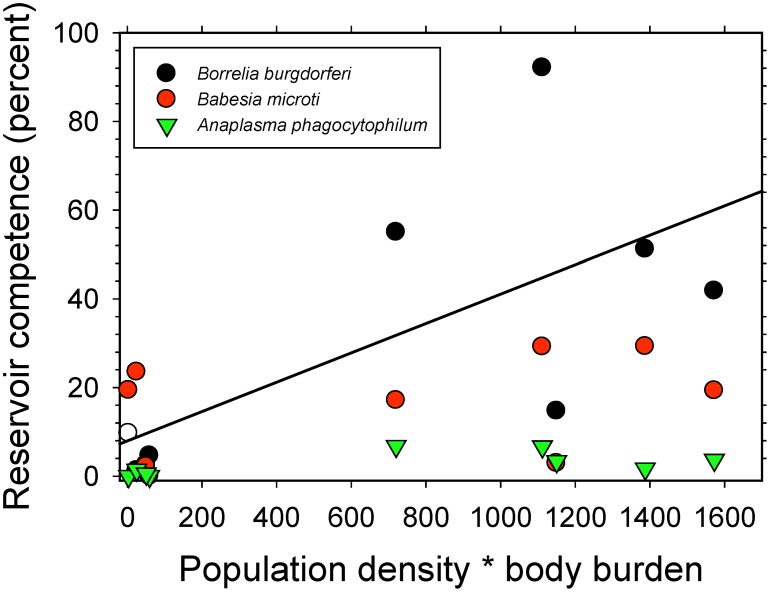
Relationship between the product of average host population density and measured body burden (number of naturally occurring larval ticks per host individual) and reservoir competence of that host species.The product of population density and body burden, which represents the average number of ticks fed by a particular population of hosts, is used as one of two proxies for encounter rates between ticks and host species.